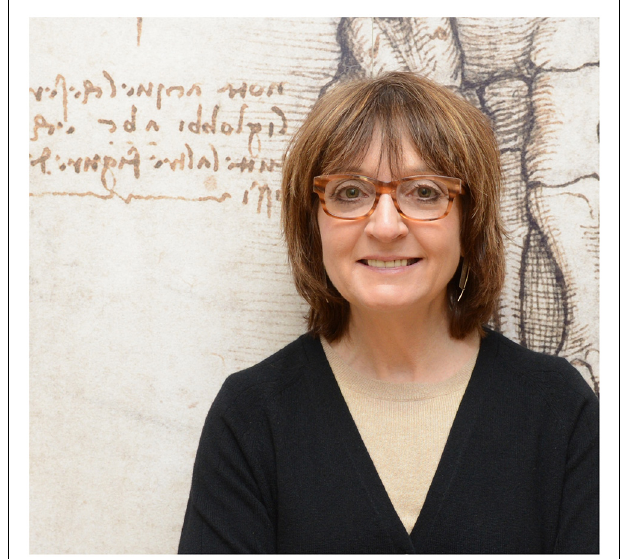
FIGURE 10 | Helene Mayberg, provided by Helene Mayberg.